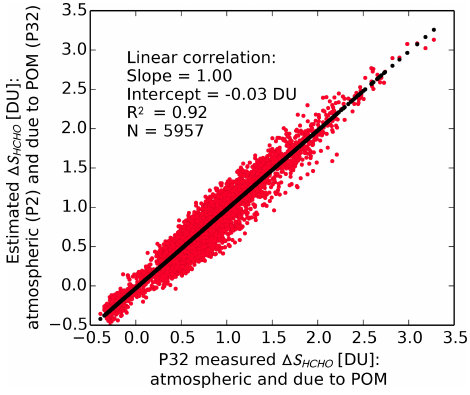
Figure 7. Linear regression analysis of the estimated and measured (cid:49)S HCHO by Pandora 32, including true atmospheric and POM- H Delrine-emitted HCHO. Pandora 2 (POM free) measured only atmospheric HCHO. Pandora 32 measured both true atmospheric abundance and POM-H Delrine-emitted HCHO. Instruments were colocated at NASA-GSFC and made direct-sun measurements from 30 August to 15 October 2019. The reference spectrum was col- = 0 . 0133 · lected around local noon on 15 October 2019: (cid:49)S hs HCHO exp ( 0 . 0911 · T hs )